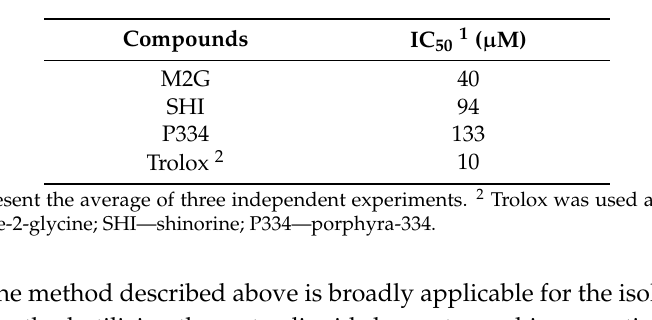
Table 2. Free radical scavenging activity monitored by 2,2 (cid:48) -azino- bis (3-ethylbenzothiazoline-6-sulfonic acid) (ABTS)